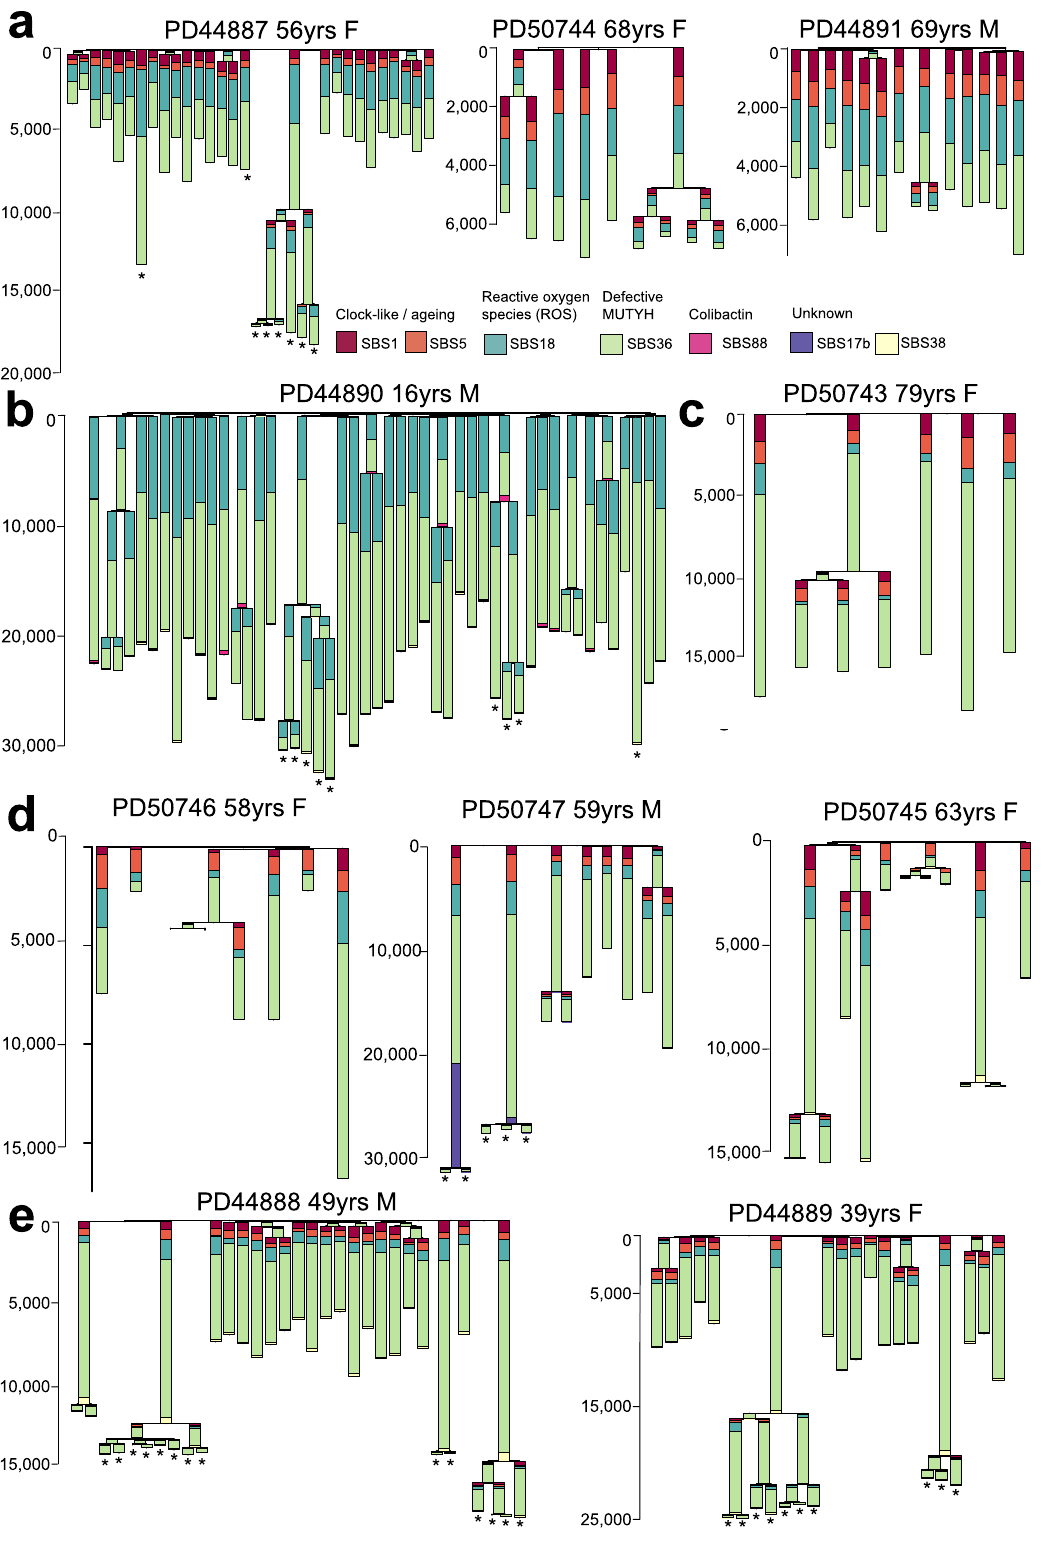
Fig. 3 Phylogenetic trees and mutational signatures in intestinal cells with germline MUTYH mutations. Phylogenetic trees per-individual reconstructed from SBS mutations in individual intestinal crypts showing the number of SBS mutations per branch. Stacked barplots are overlaid onto each branch to represent the proportion of each mutational signature contributing to that branch. Phylogenetic trees are arranged by MUTYH germline mutation; a MUTYH Y179C + / − G396D + / − b MUTYH Y179C + / − G396D + / − with OGG1 germline mutations, c MUTYH G286E + / + , d MUTYH Y179C + / + and e MUTYH Y104* + / + . Adenoma glands bearing cancer driver mutations are indicated with an asterisk ‘ * ’ . Source data are provided as a Source Data fi le.